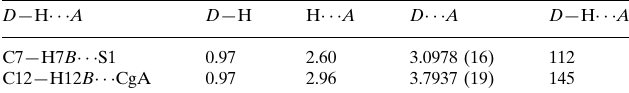
Hydrogen-bond geometry (A˚ , (cid:2)